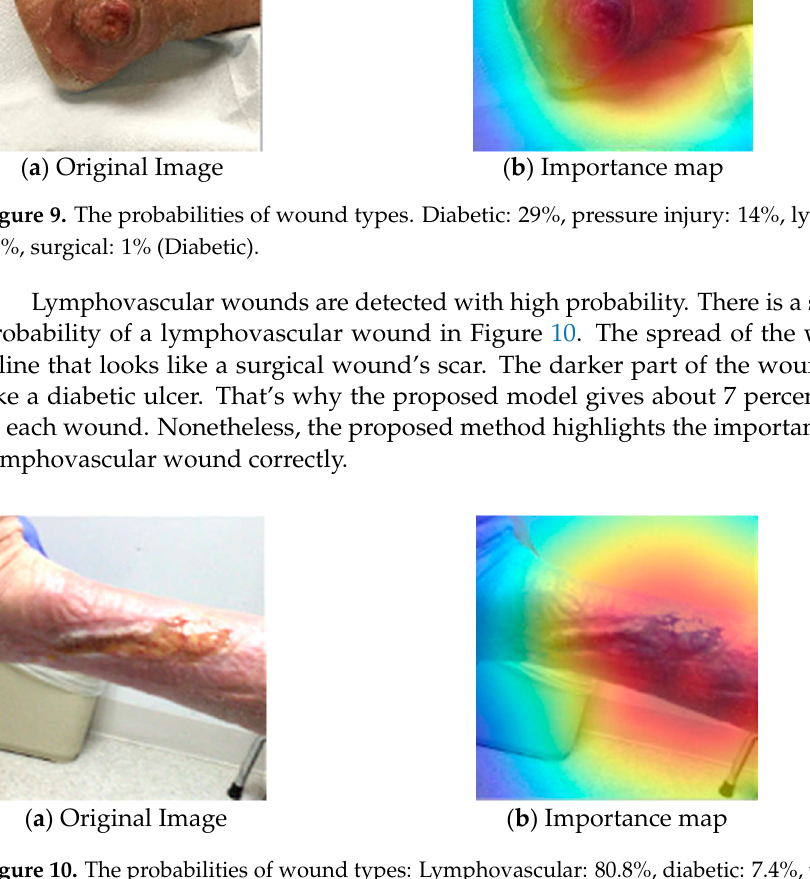
Figure 11. The probabilities of wound types: Pressure injury: 27.3%, lymphovascular: 12%, surgical: 2.6%, diabetic: 58.2% (Pressure injury).